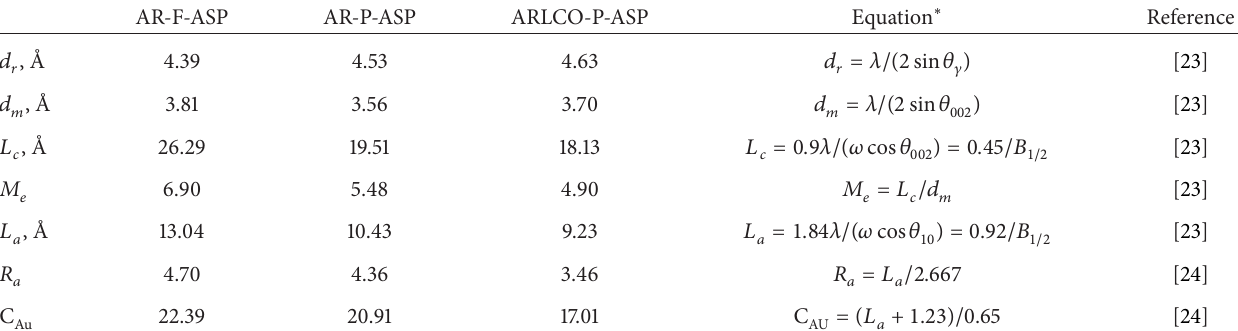
Table 2: Structural data obtained by XRD.